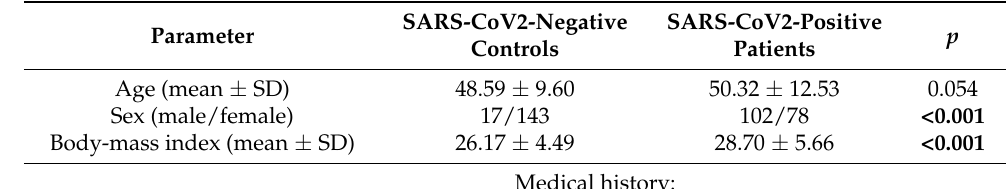
Table 1. Preoperative characteristics of the study groups—mean values ± SD. Statistically significant p values are shown in